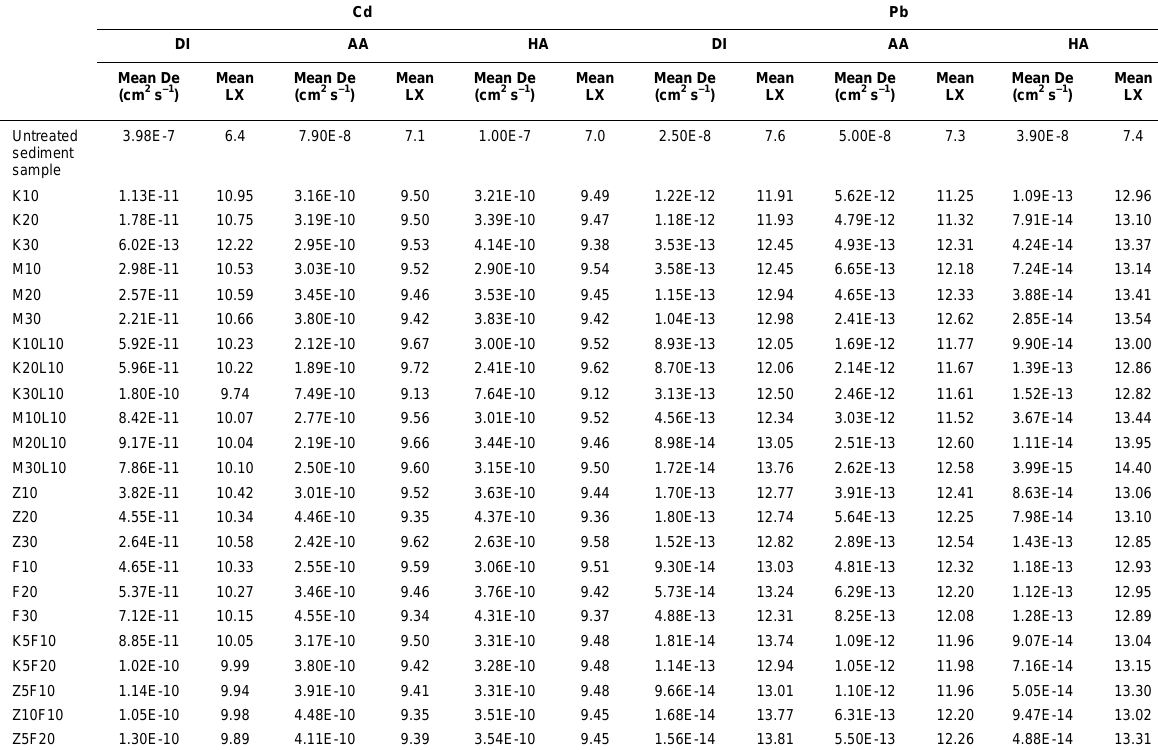
Mean Effective Diffusion Coefficient (De) and